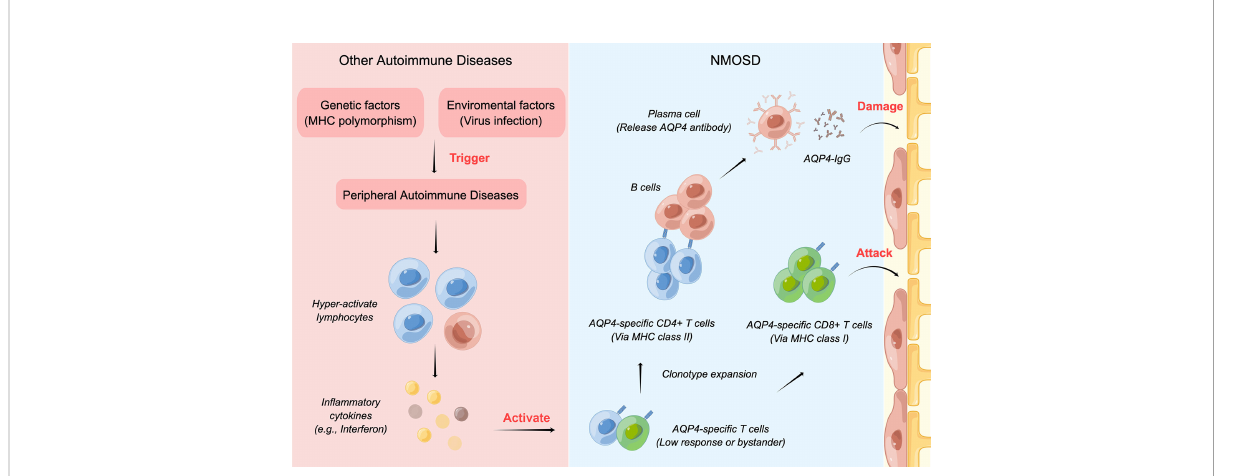
FIGURE 6 The mechanism of NMOSD coexisting with other ADs. Both environmental and genetic factors contribute to the pathogenesis of peripheral ADs. After peripheral ADs occur, lymphocytes may become hyperactive and produce high levels of in fl ammatory cytokines, which would activate the low-response or bystander T cells speci fi c to AQP4. Then, the astrocytes would be attacked by AQP4-speci fi c CD8+ T cells and the AQP4-IgG